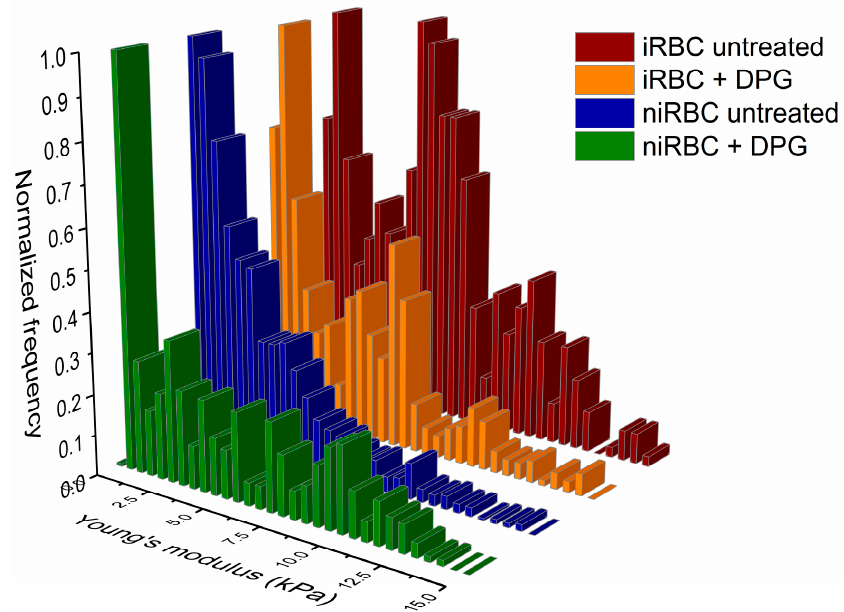
Figure 1. Histograms of RBC stiffness (Young’s modulus) measured by AFM force spectroscopy of infected and noninfected RBCs after 30 h of incubation with or without 2,3-DPG 8 mM. Parasites in infected samples were at the trophozoite stage. This figure includes data from three independent experiments. iRBC + DPG—infected RBCs treated with 2,3-DPG ( n = 1573); iRBC untreated—untreated infected RBCs ( n = 1126); niRBC + DPG—noninfected RBCs treated with 2,3-DPG ( n = 1358); niRBC untreated—untreated noninfected RBCs ( n = 1273). All descriptive statistics and p -values generated by Dunn’s multiple comparisons test are presented in Table